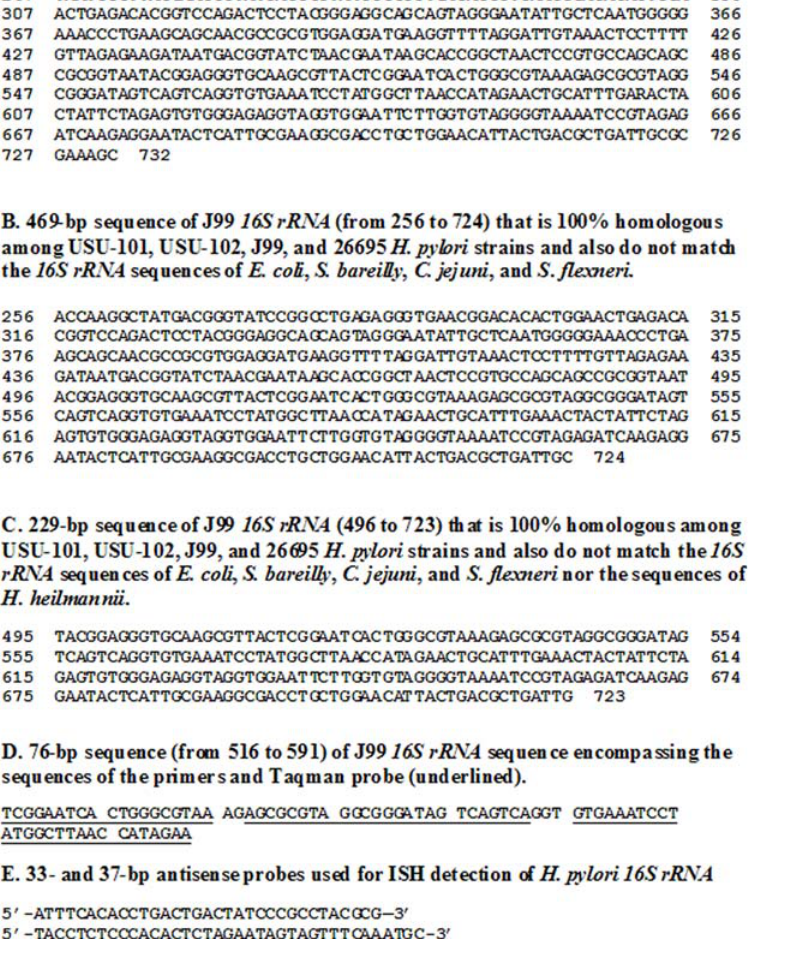
Figure 2. Sequences of H.pylori16SrRNA that are 100% homologous among USU-101, USU-102, J99, and 26695 H.pylori strains (A), and also do not match the 16SrRNA sequences of E.coli , S.bareilly , C.jejuni , and S.flexneri (B), nor the sequences of H.heilmannii (C), and encompass the set of primers and TaqMan probe (D). E shows the sequences of the two ISH probes used in the present study (546-bp from 187 to 732 of J99 16S rRNA